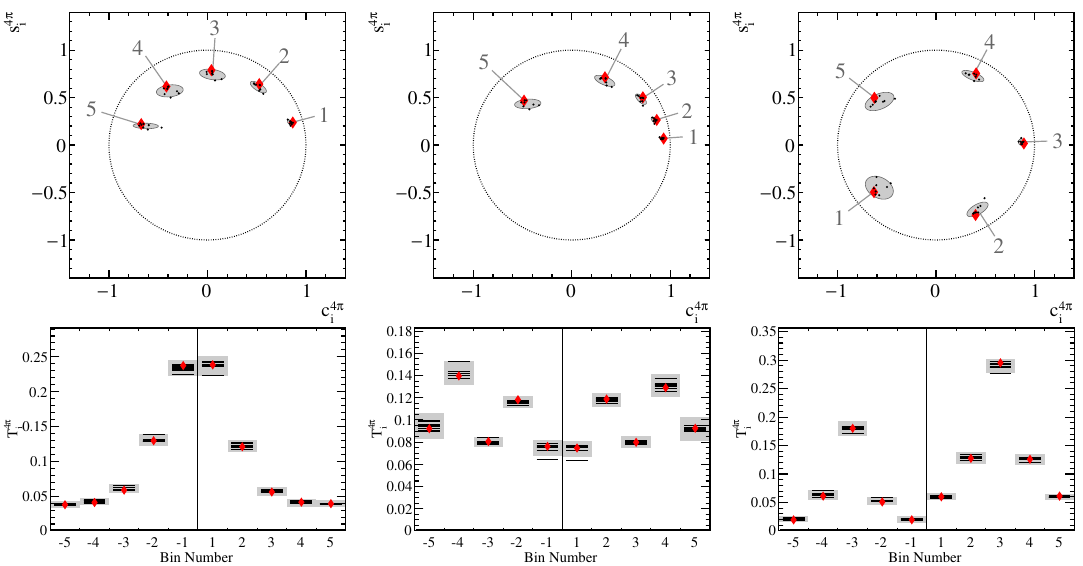
Figure 3 . The model predictions of the hadronic parameters for the (left) equal (cid:1) (cid:14) 4 (cid:25) (centre) variable (cid:1) (cid:14) 4 (cid:25) binning (right) alternative binning, with N = 5. (top row) The red diamonds p (black dots) show the c f and s f predictions calculated from the baseline model (alternative models). i i The grey shaded ellipses shows c f and s f model prediction and uncertainty as described in the text. i i (bottom row) The (red diamonds) black horizontal lines show the T f from the baseline model (alternative models). The grey shaded band shows the T f prediction and uncertainty as described in the